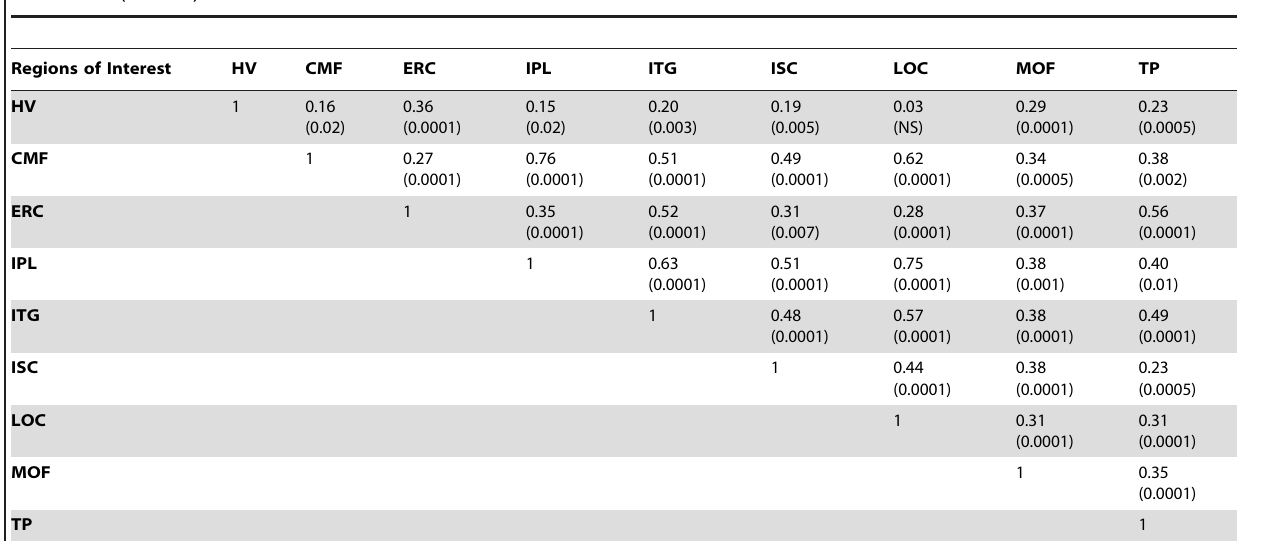
Table 5. Correlation results between cortical thickness of eight neocortical ROIs and total hippocampal volume in only CN individuals (n=208).